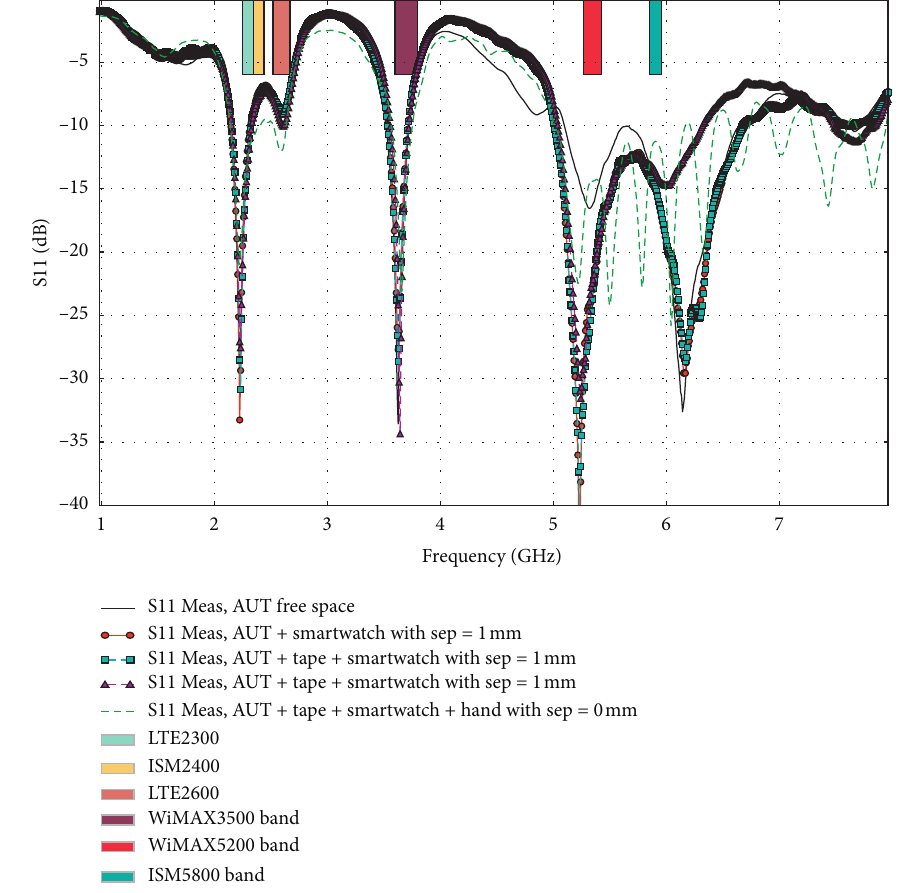
Figure 14: Influence of the smartwatch on the antenna S11. Table 3: Comparison of the proposed design to state-of-the-art antennas. References Antenna